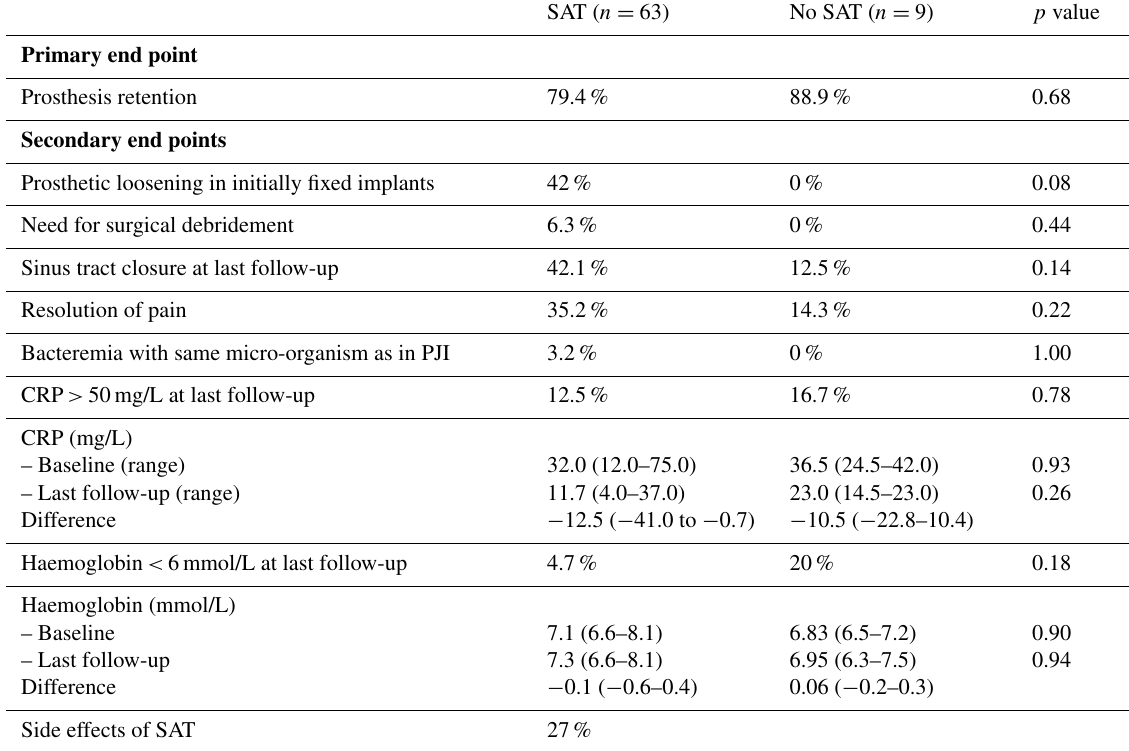
Table 3. Primary and secondary end points of suppressive antibiotic treatment (SAT) vs. no